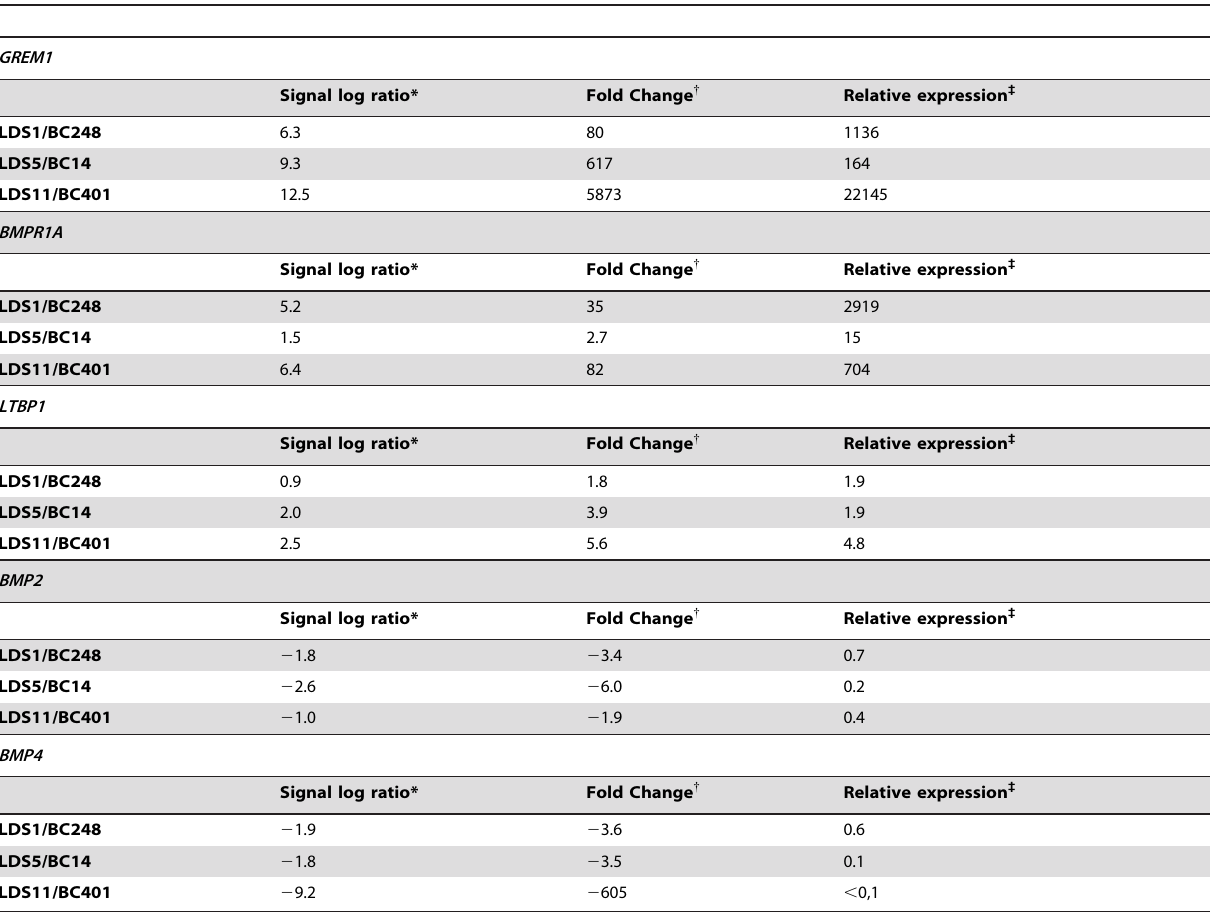
Table 4. Members of the TGF- b superfamily with altered mRNA expression levels in LDS-OECs compared to healthy